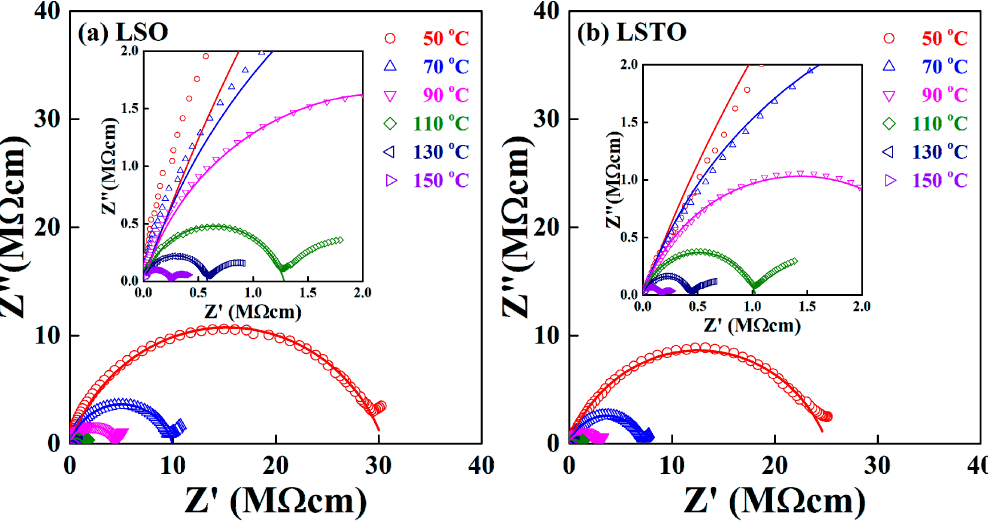
Figure 2. Complex impedance Cole − Cole plot of ( a ) LSO and ( b ) LSTO glasses, measured at various temperatures. Inset shows the extended complex impedance patterns at a high frequency regime.